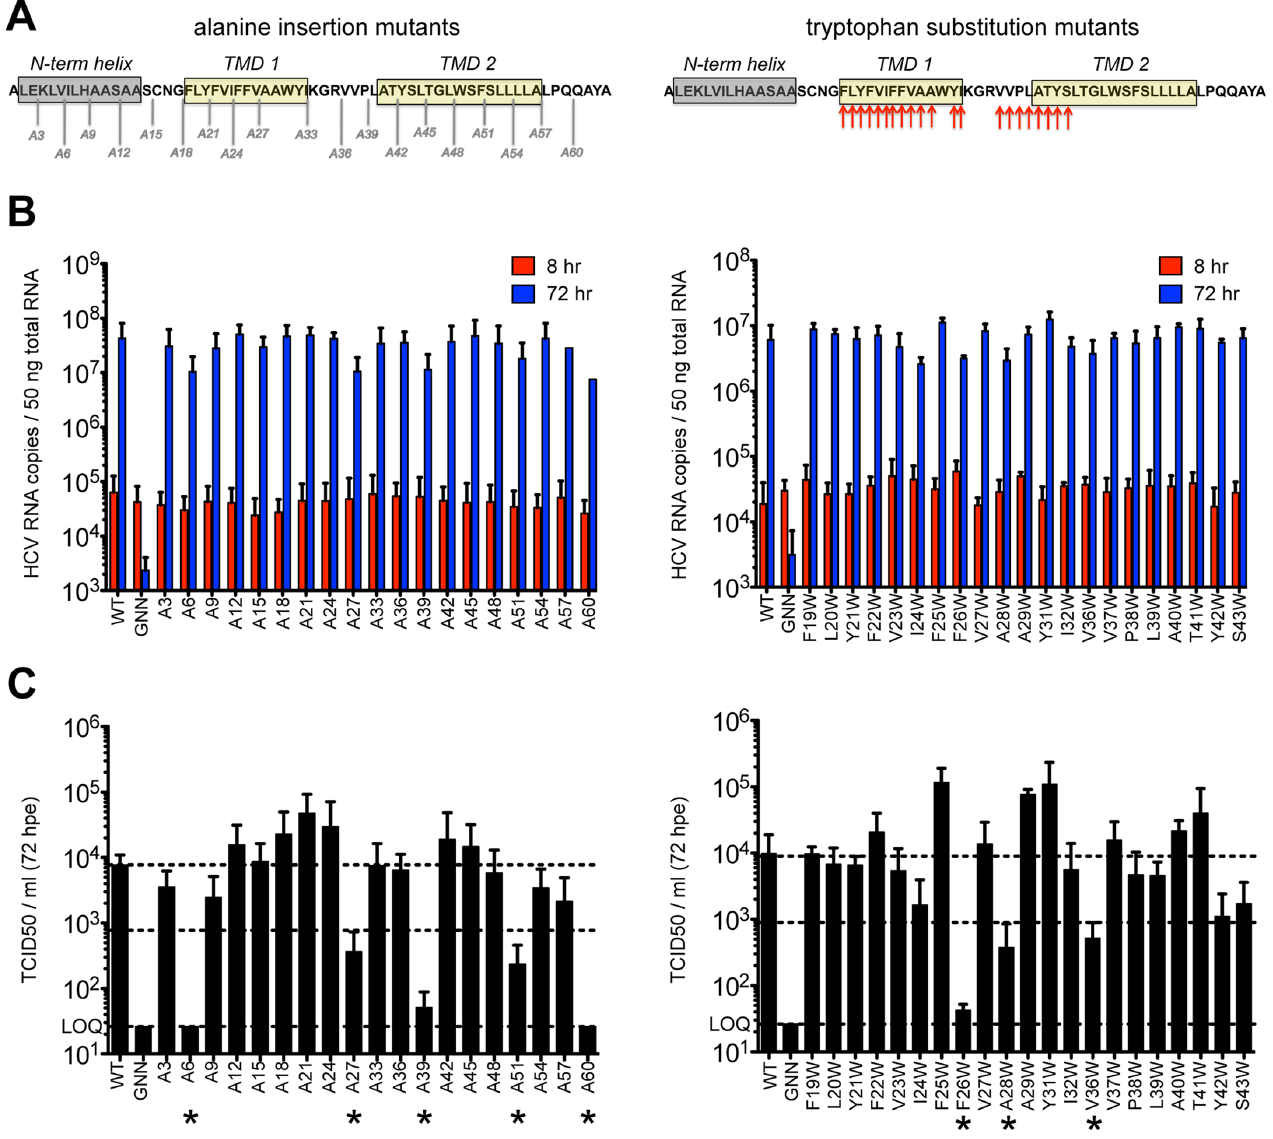
Fig 1. Large-scale mutagenesis of p7 has little impact on infectious virus production. A) Cartoon of the alanine insertions and tryptophan substitutions generated in J6/JFH p7. The secondary structure boundaries shown were previously deduced from p7 NMR data using HCV-J (genotype 1b) in 50% TFE [41]. B) HCV RNA levels in Huh-7.5 cells determined 8 and 72 hours post-electroporation (hpe). GNN is a replication-defective genome containing a double mutation within the RdRp motif of NS5B (GDD to GNN). C) Infectious virus in the supernatants of electroporated Huh-7.5 cells quantified by limiting dilution assay. Asterisk ( * ) indicates p7 mutant genomes that yielded > 1 log decrease in TCID50 / ml compared to WT (compare middle and upper dashed lines). LOQ: lower limit of the limiting dilution assay. Bar graphs in all figures depict mean, +/- standard deviation across a minimum of 3 independent electroporations. Results were confirmed using RNA generated from independent transcription reactions and replicate